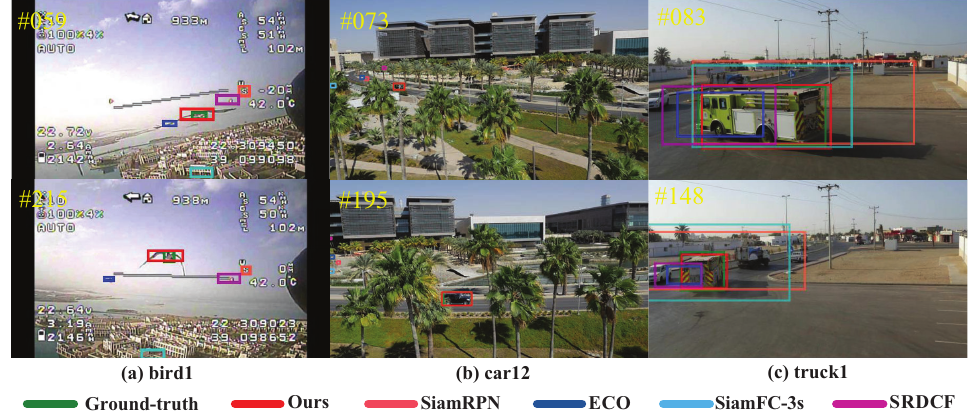
Figure 1. Comparison of proposed tracker with other existed methods (SiamRPN [14], ECO [15], SiamFC-3s [16], SRDCF [17]) on the bird1, car12 and truck1 from UAV123